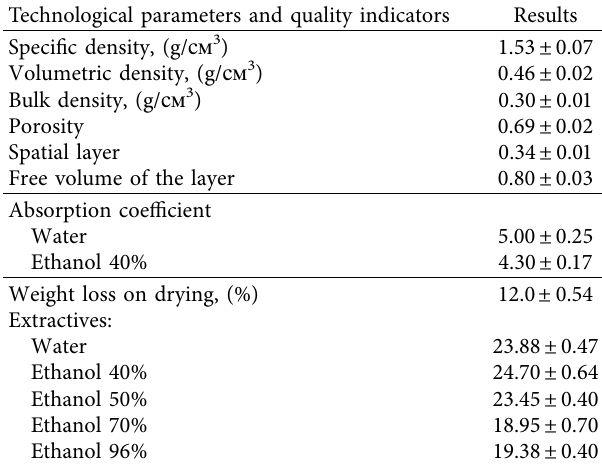
Table 1: Results of corn silk technological parameters and quality indicators